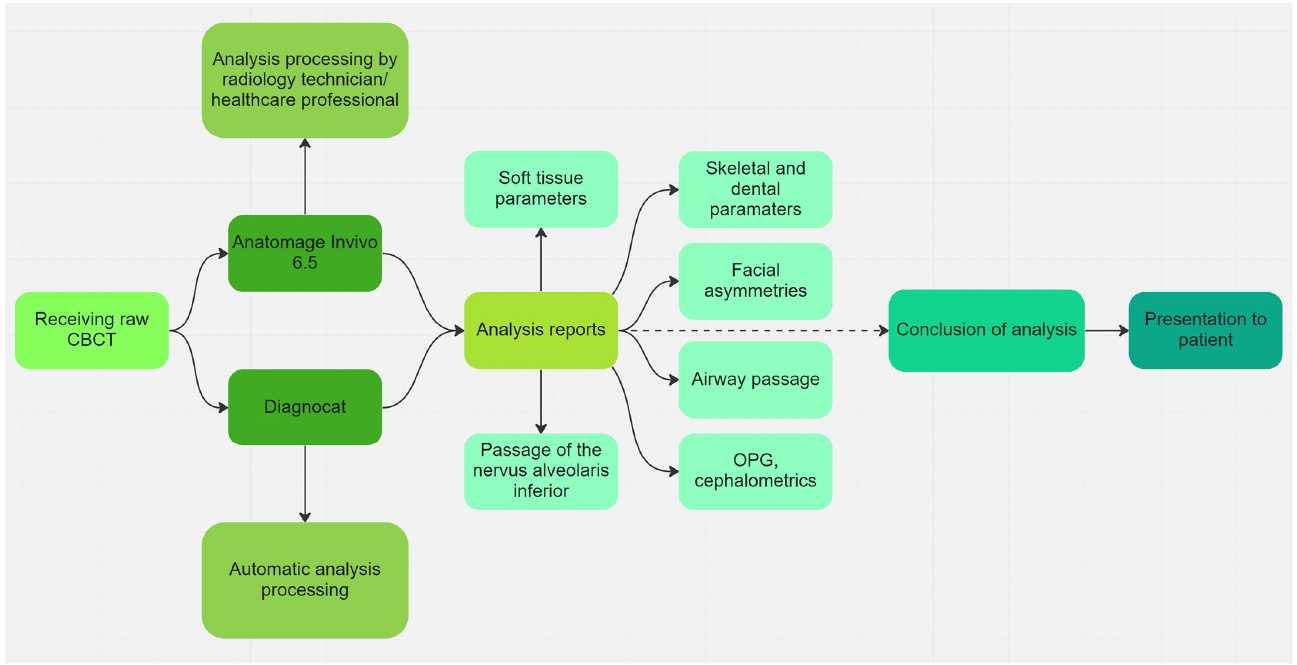
Figure 1. Scheme of processing and segmenting CBCT into the final form and its presentation to the patient.